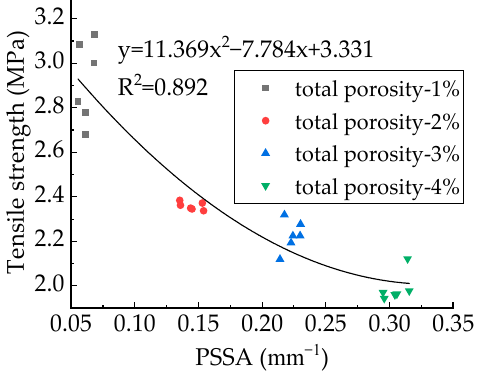
Figure 23. Relationship between PSSA and tensile strength.